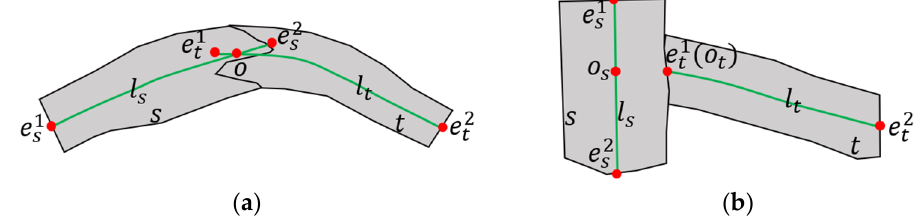
Figure 6. A schematic diagram for extracting the nodes from adjacent clusters. ( a ) A case when l s and l t have intersection points. ( b ) A case when l s and l t do not have intersection points.